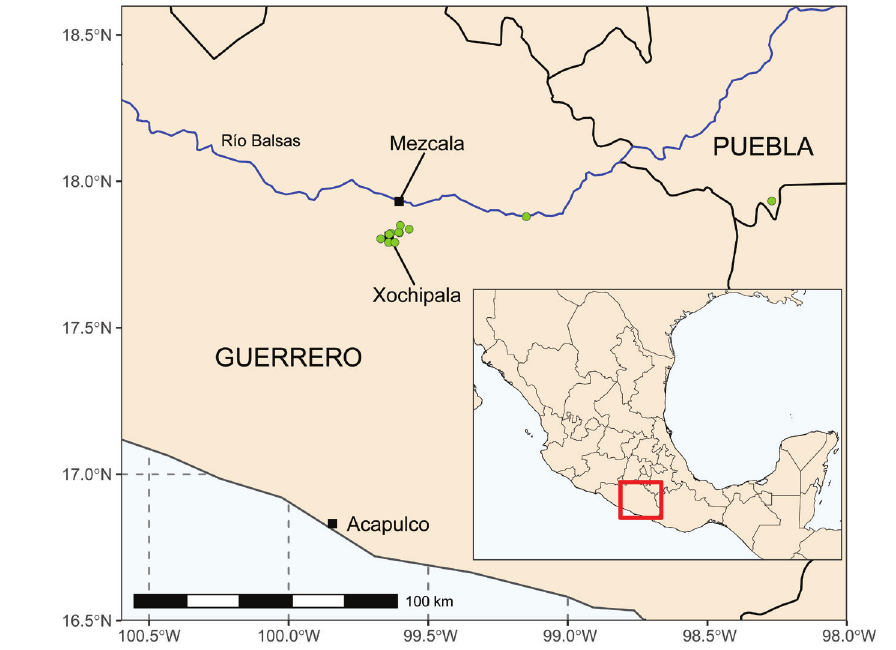
Figure 3. Distribution of Mezcala balsensis in the central Balsas Depression in Guerrero, Mexico. Map based on 15 quality-controlled species occurrence records from GBIF (www.gbif.org), SEINet (www. swbiodiversity.org/seinet), and Contreras (1986), created using R packages ggplot2 (Wickham 2016), sf (Pebesma 2018), and rnaturalearth (South 2017), with data layers depicting Río Balsas and borders of Mexican states downloaded from the North American Environmental Atlas (www.cec.org/north-ameri-